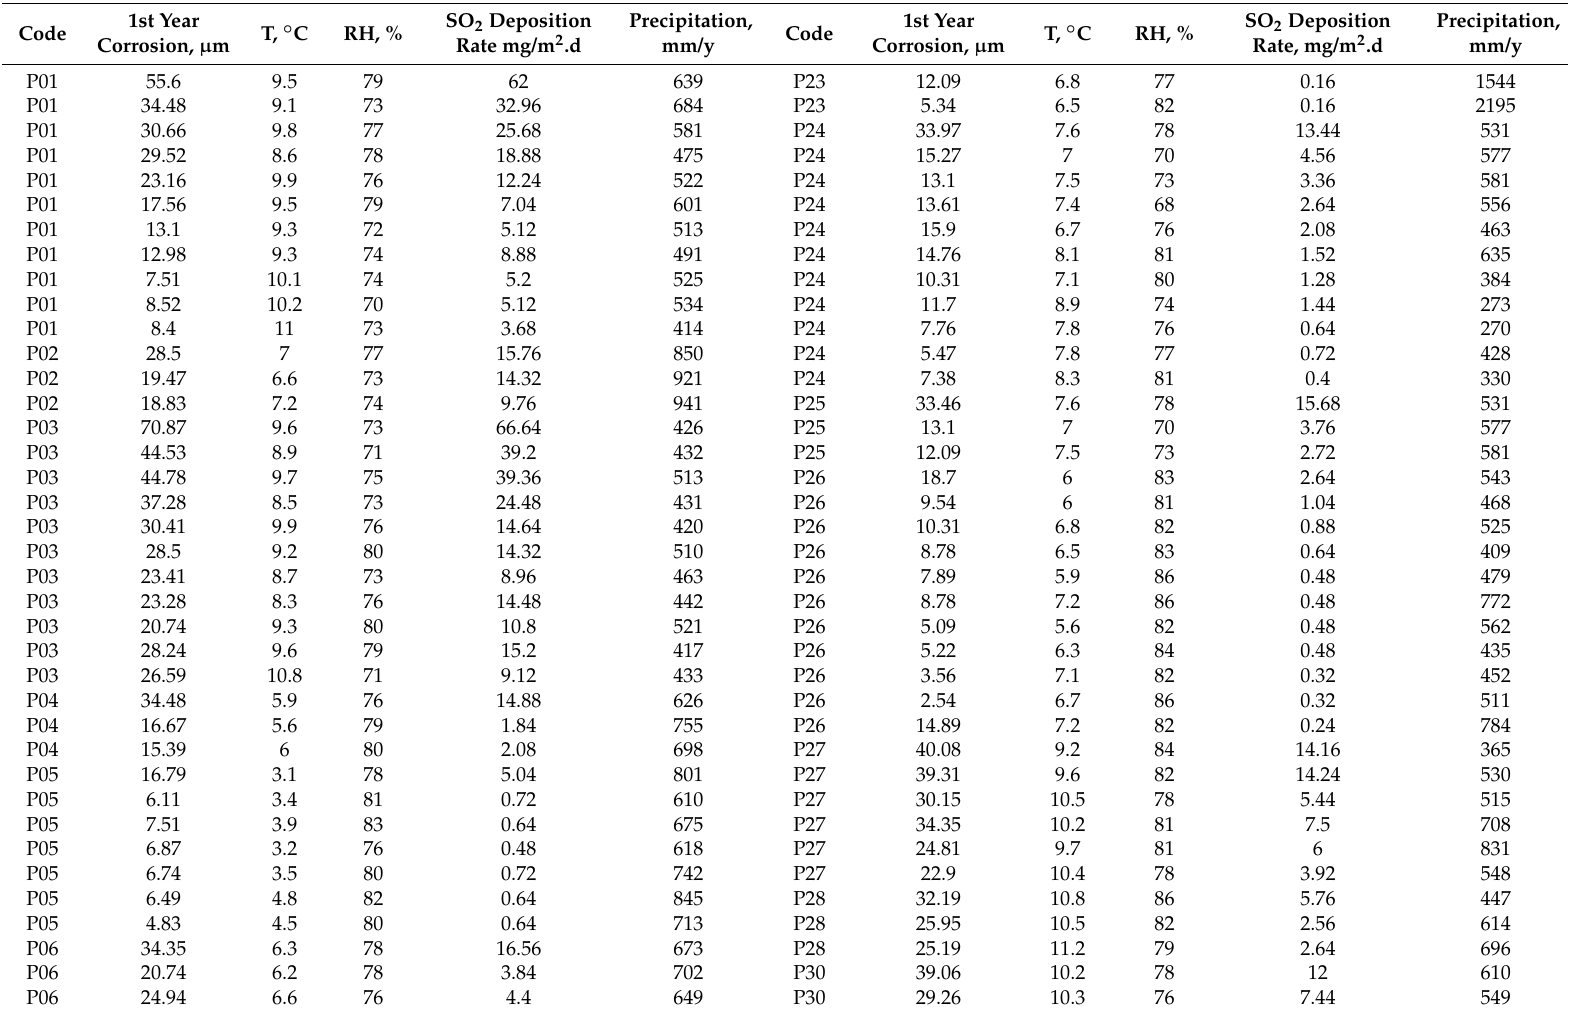
Table 4. ICP/UNECE data considered in the